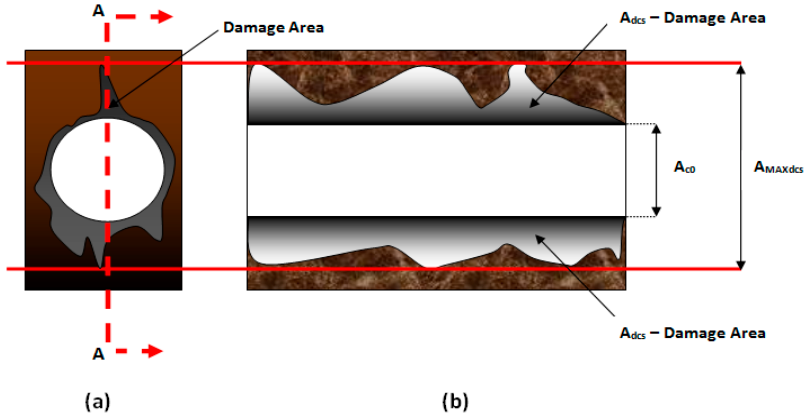
Figure 1. Quantification of the damage area inside the through hole: ( a ) cross-section reference points at the top view of the through hole and ( b ) cross-section view from the point A—A inside the hole.